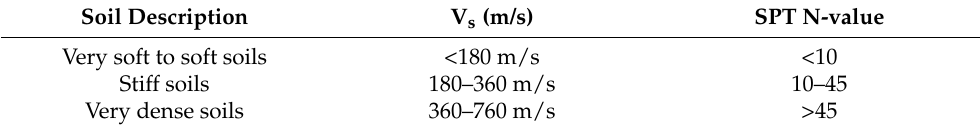
Table 6. Simplified correlation of V s and SPT-N for different soil strength classifications in this study. Soil